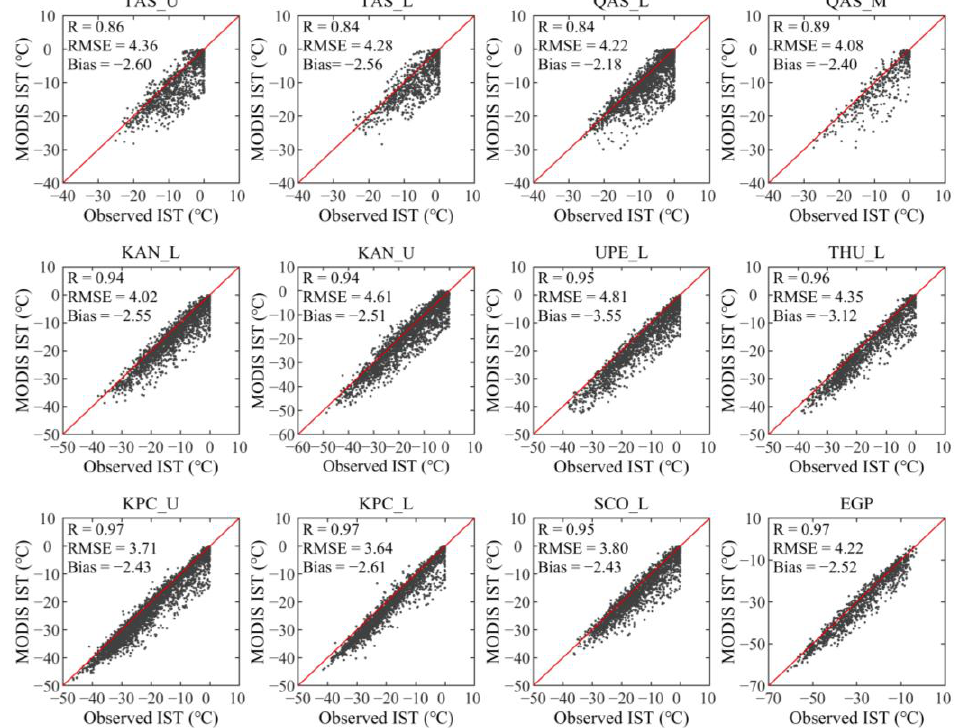
Figure 2. MODIS and observed daily IST, the red diagonal represents the 1:1 line. Statistics show Correlation coefficient (R), root mean squared error (RMSE), and bias.